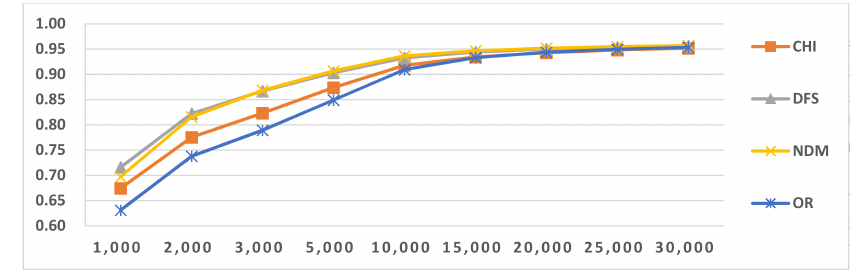
Figure 7. Results of LI in Latin script languages when selecting SVM and